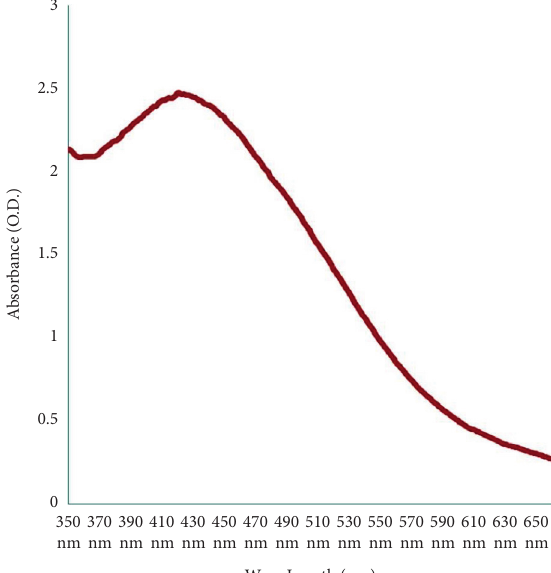
Figure 1: UV-vis absorption spectra of AgNPs using B. lanzan Spreng leaf extract.